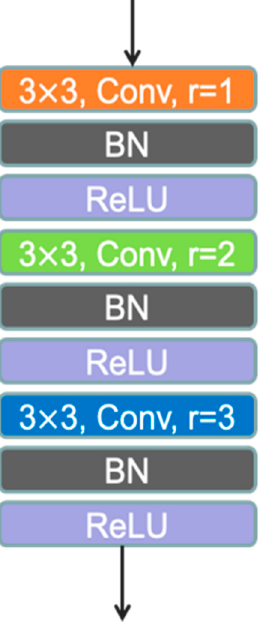
Figure 5. HDC Block. The HDC block consists of three convolution layers with kernel size 3 and dilation rates of r = 1, 2, 3, respectively, three batch normalization layers, and three ReLU activation functions.